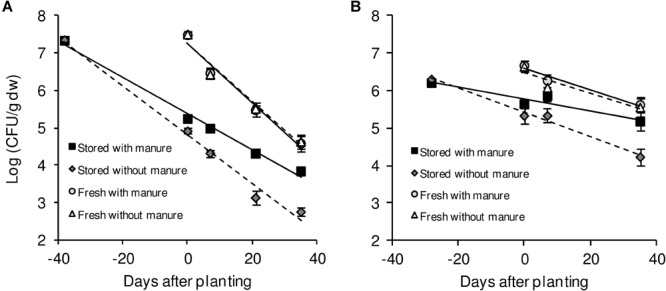
CFU counts of S. Typhimurium 14028s in DS and AL soil. Exemplarily shown is the decrease of S. Typhimurium 14028s colony forming unit (CFU) counts in diluvial sand (DS) (A) and alluvial loam (AL) (B) soil treated with or without pig manure. The Salmonella strain was introduced together with manure application (stored) or on day 0 directly before planting of lettuce (fresh). Shown are the mean values for treatments and respective standard deviations (n = 8). Samples with lettuce and corn salad as crop plants were averaged. Solid and dashed lines indicate linear regressions for soil treated with manure or without manure, respectively.